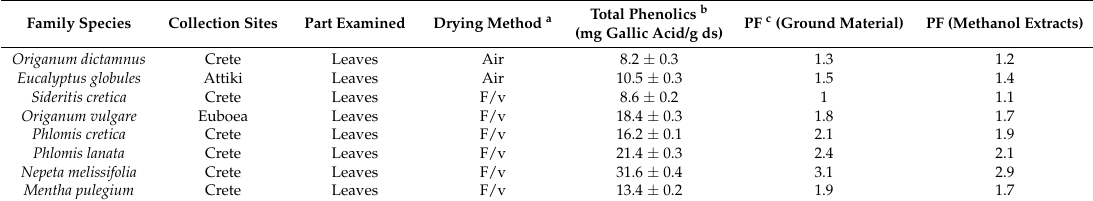
Table 1. Total Phenolics in Plant Extracts and their Antioxidant Capacity (Expressed as PF Values). Family